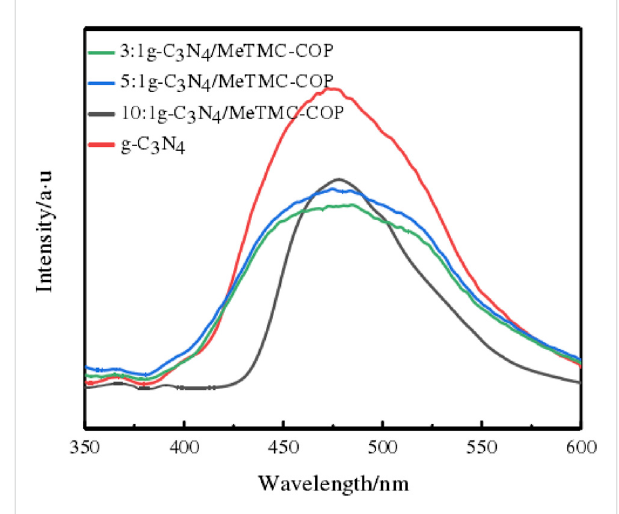
FIGURE 6 UV-Vis diffuse emission spectra of g-C 3 N 4 and different ratios of g-C 3 N 4 /MeTMC-COP.